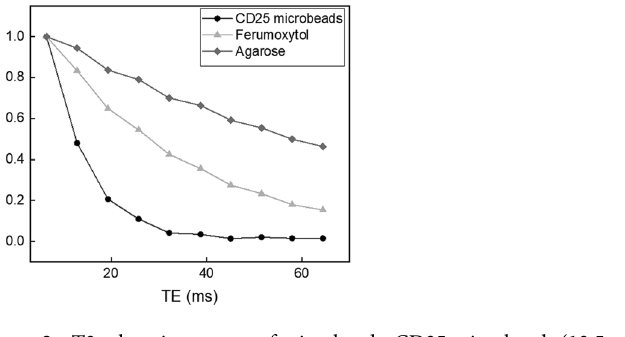
Figure 3. T2 relaxation curves of microbeads. CD25 microbeads (12.5 µgFe/ml) and ferumoxytol (12.5 µgFe/ ml) display shortened T2 relaxation compared to agarose gel which exhibits linear signal decay with respect to echo time.